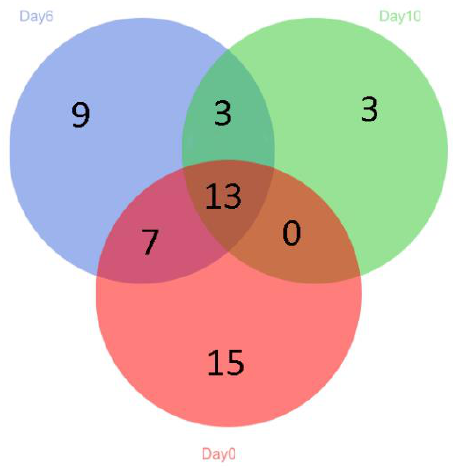
Figure 2. Venn diagram showing the distribution (97% similarity) of the genera levels present in the samples of grouper stored at 4 °C for 10 days. Each number represents a shared or unique genus in the samples in each sampling day. Different color indicates different sampling days (day 0 = red, day 6 = blue and day 10 = green).